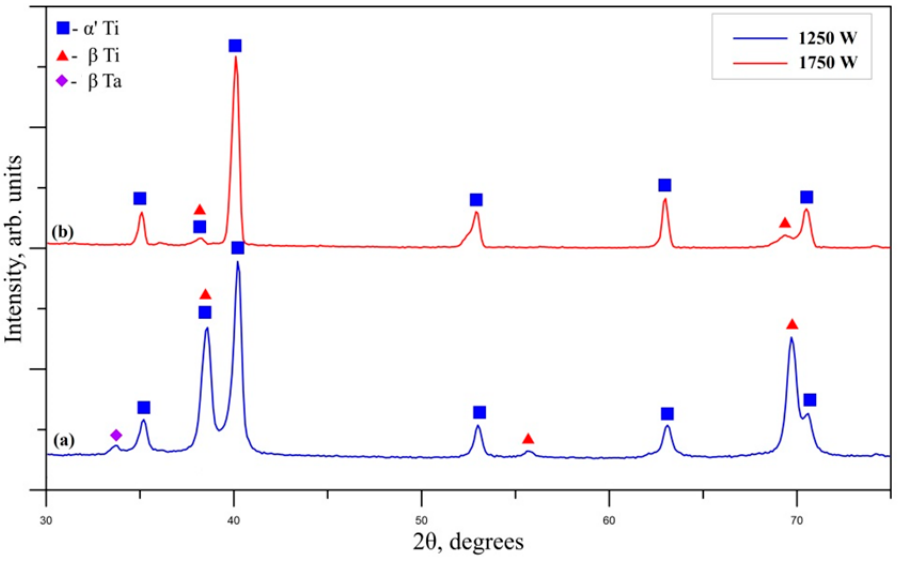
Figure 5. X-ray diffraction patterns of the specimens alloyed with a beam power of 1250 W ( a ) and 1750 W ( b ).